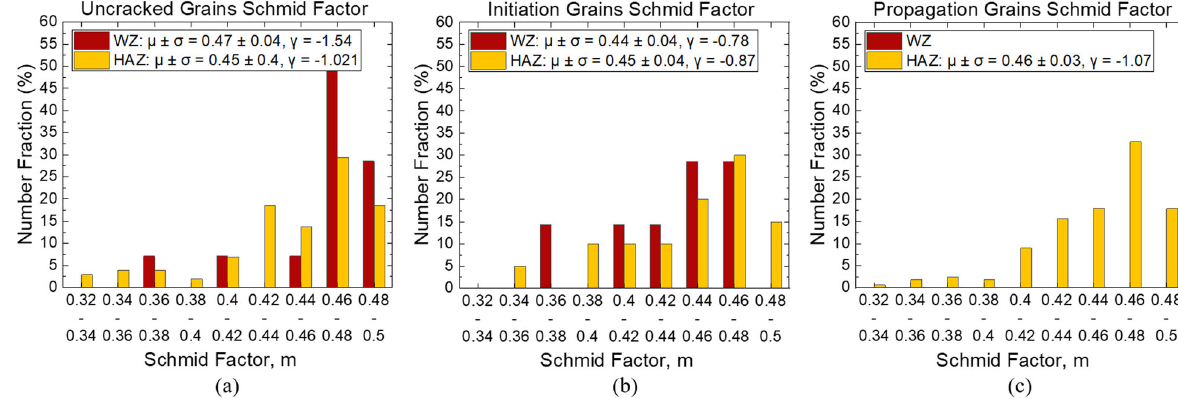
Fig. 4 Schmid factor distributions. a Uncracked surface grains; b surface initiation grains; c propagation grains along crack path.